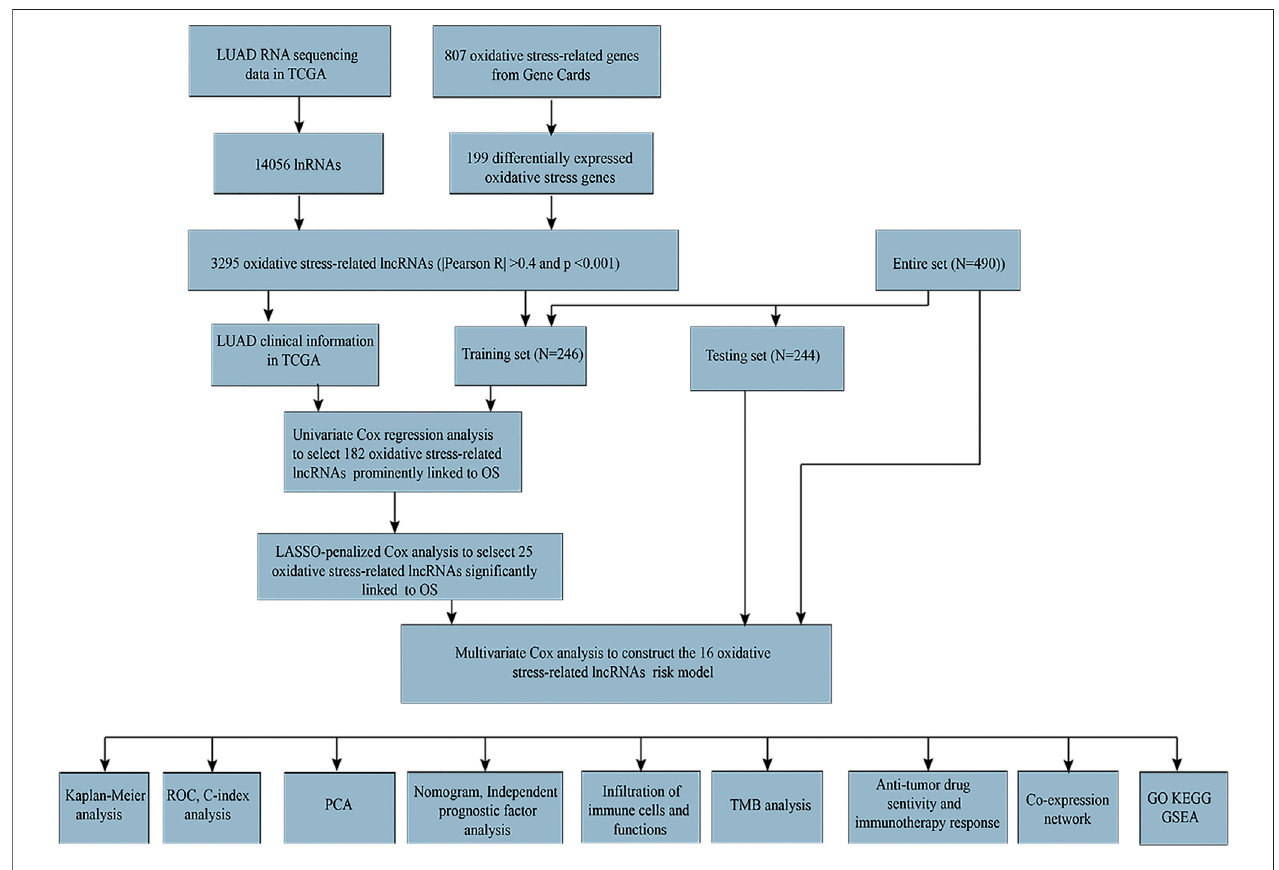
FIGURE 1 | Flow diagram of complete data